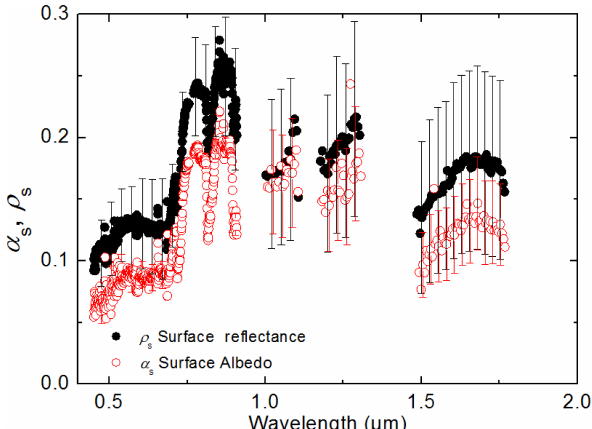
Figure 2. Mean surface albedo α s ,λ and surface reflectance ρ s ,λ measured over Zhongshan on 3 December 2009. The data were av- eraged for a time period of 40min where the flight altitude was 4100m and the SZA ranged between 45.7 and 48.7 ◦ . The standard deviation is displayed as vertical